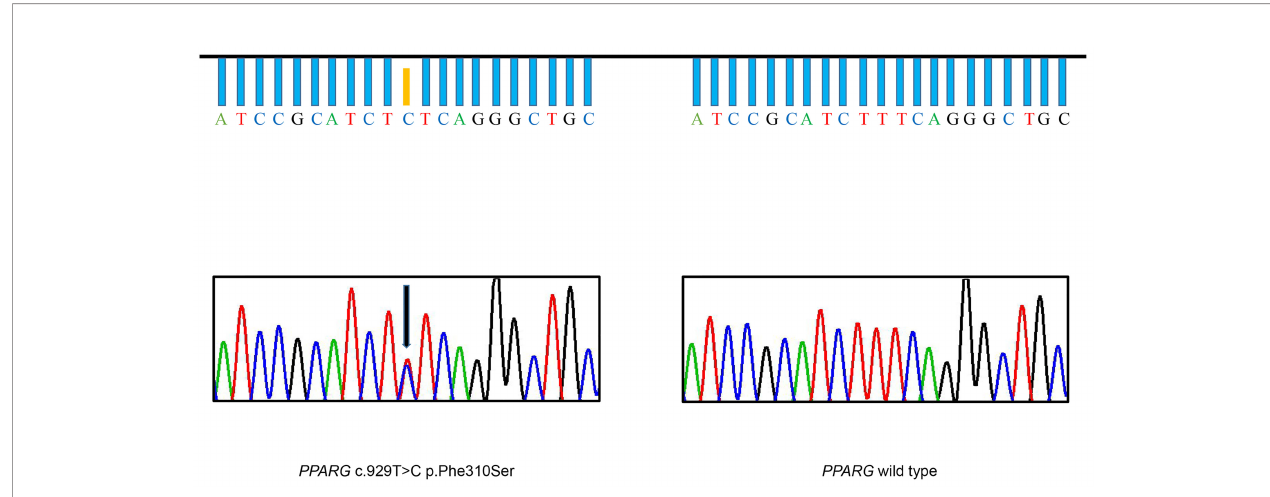
FIGURE 2 | Identi fi cation of the F310S mutation. DNA sequencing chromatogram of a portion of the PPARG gene, illustrating that thymine was substituted with cytosine, leading to heterozygous substitution of phenylalanine by serine in the patient (arrow). The DNA sequencing chromatogram of the wild-type, lacking the mutation, is shown on the